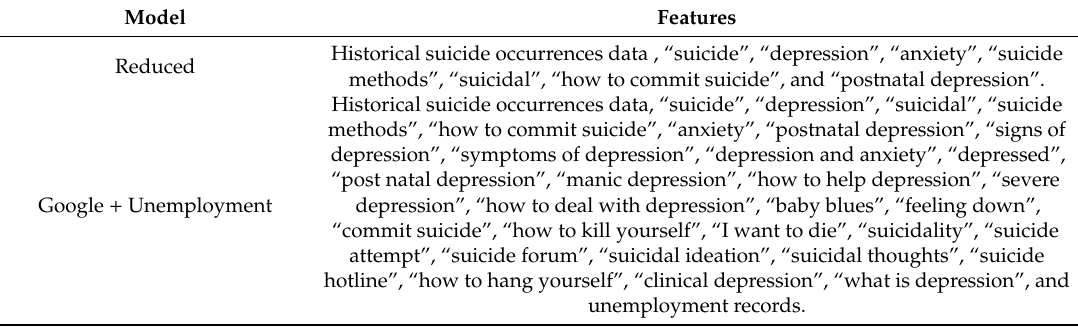
Table A1. Features utilized in the reduced and GU models. The models also include historical suicide